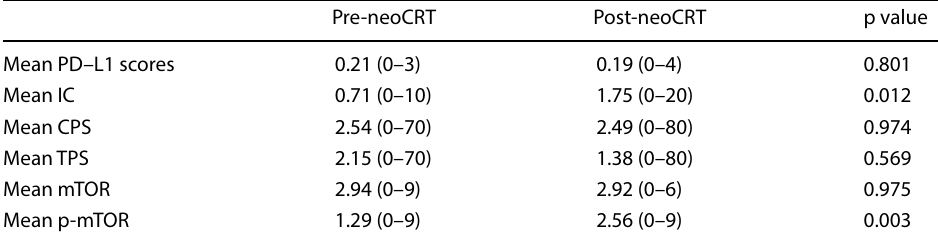
Table 3 mTOR signaling pathway and PD-L1 expression for